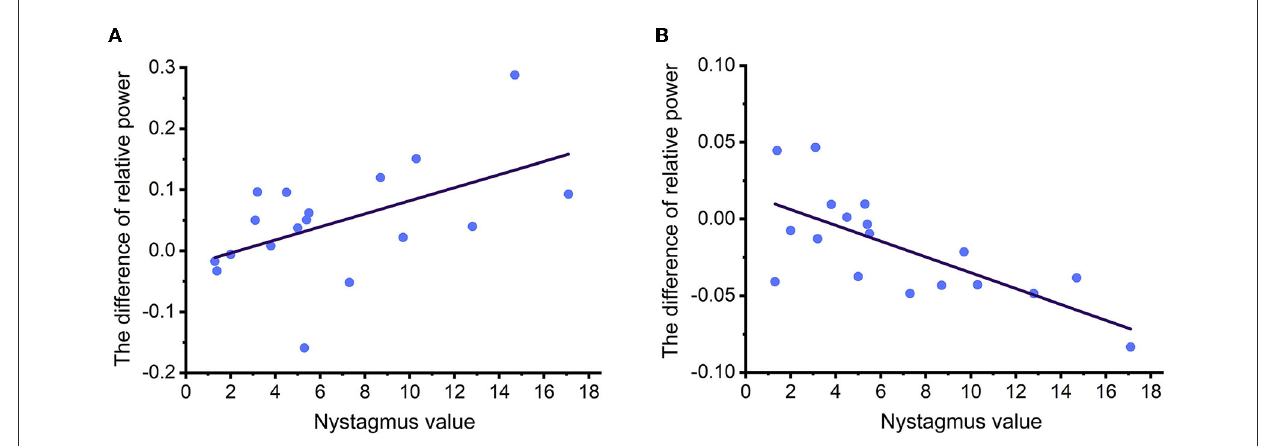
FIGURE6 (A, B) The fitting curve of correlation coefficients between relative power of EEG rhythms and nystagmus values under LW